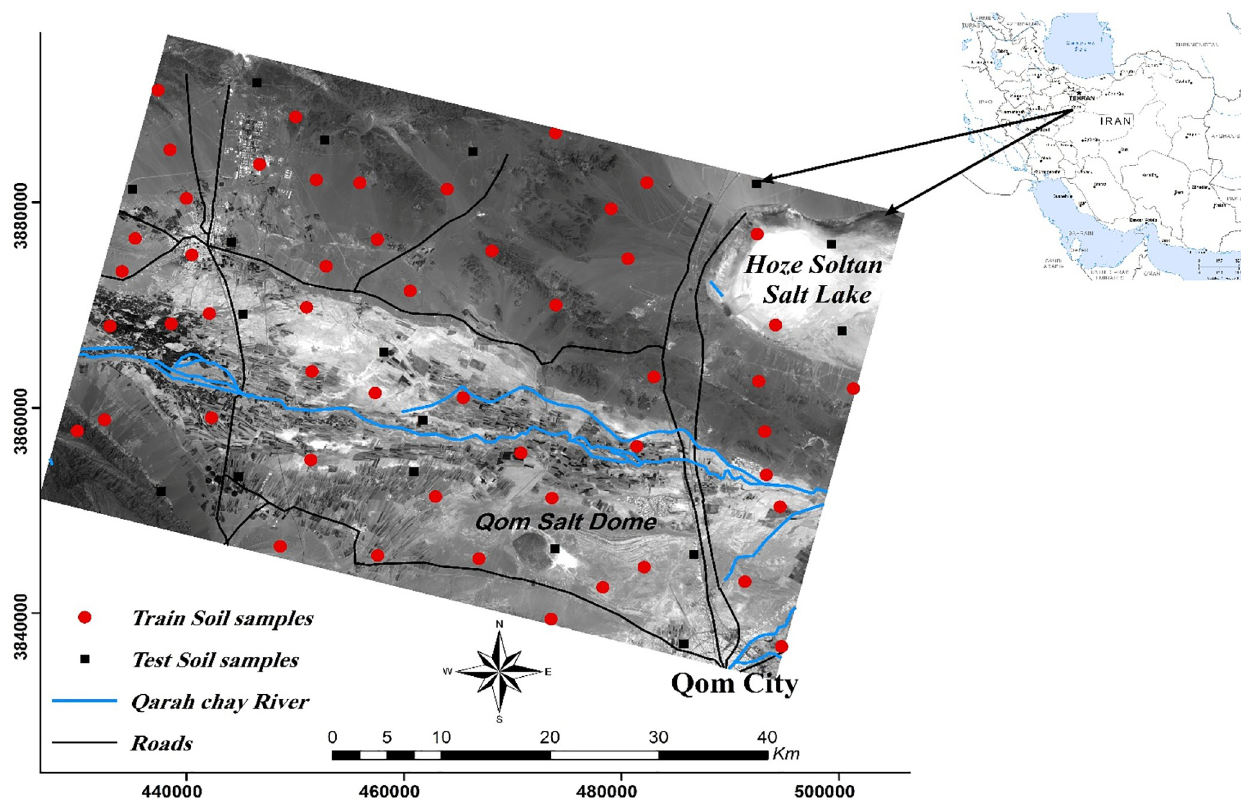
Fig 1. The study area bounded by the city of Qom to the southwest, by a salt dome to the south and by the Hoze-Soltan playa to the